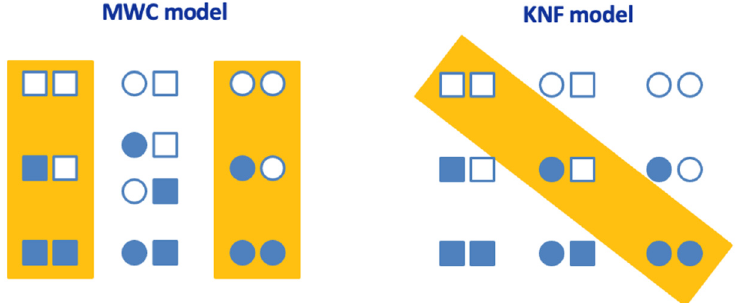
Figure 1. Cooperativity models in oligomeric proteins. The general allosteric model for a protein with two binding sites is shown. Each subunit can adopt two conformationally and functionally different conformations: T (tense) conformation (square), and R (relaxed) conformation (circle). The orange rectangle encloses the relevant conformational states in each model. Empty and filled subunits represent ligand-free and ligand-bound subunits, respectively.